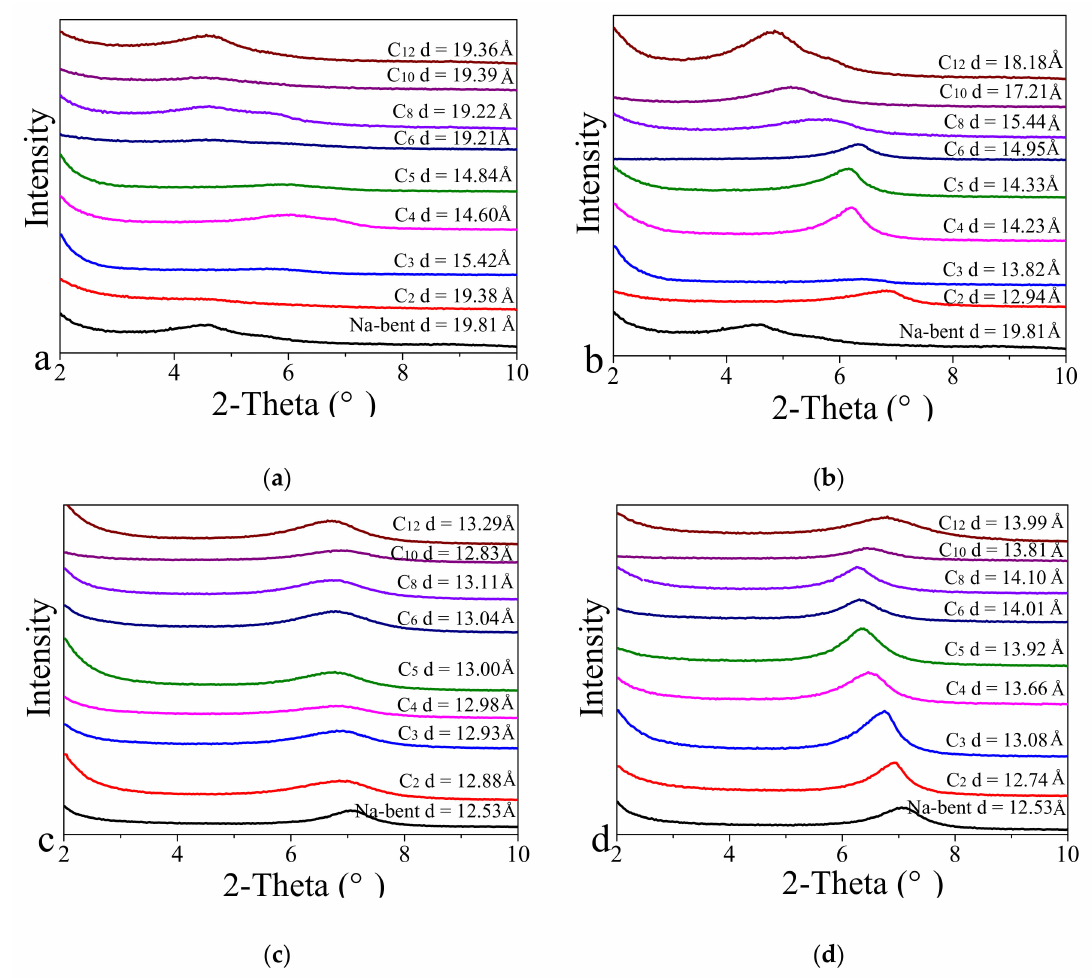
Figure 2. XRD spectra of wet and dry Na-bent samples in the presence of different ILs: ( a ) wet sample at low concentration; ( b ) wet sample at high concentration; ( c ) dry sample at low concentration; ( d ) dry sample at high